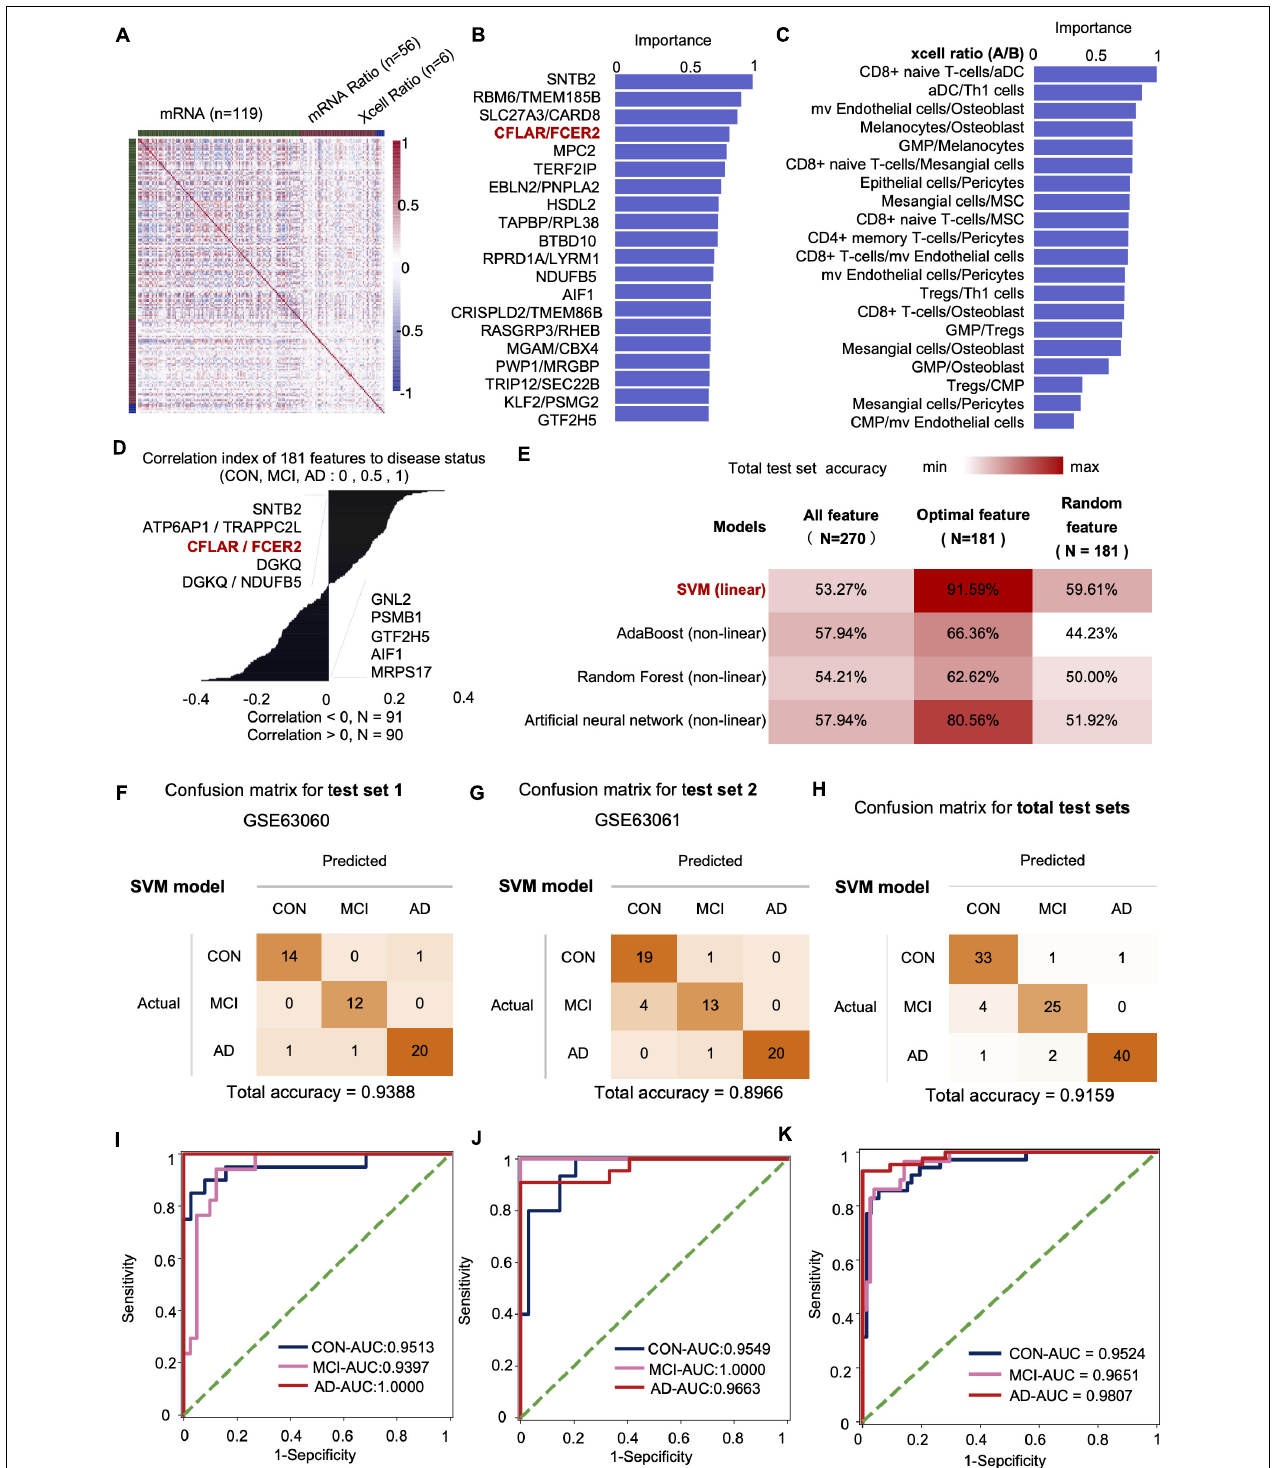
FIGURE 4 | The mRNA and XCell ratio data-based feature engineering and AI-modeling of CON, MCI, and AD. (A) Feature type correlation heat map, an overview of the correlations between features after feature engineering. (B) Top 20 features importance (from optimal 181 features set). (C) XCell-Ratio of the top 20 in importance. The numbers represent the abundance of different cells in CON, MCI and AD. (D) The 181 features relevance between features and labels. (E) Compare the prediction accuracy on test set between different models and different features. (F–H) Confusion matrix of test set. (I–K) ROC curve of the SVM model developed by optimal